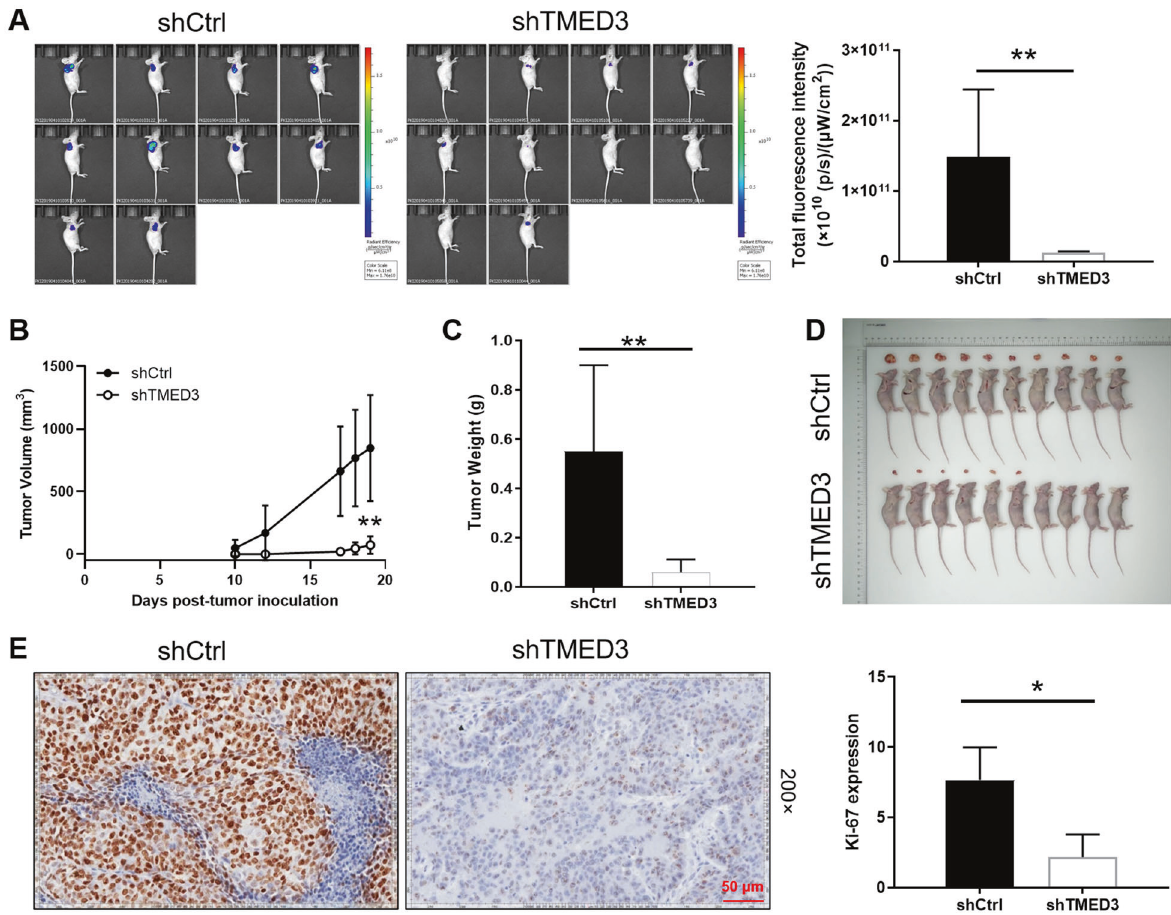
Fig. 3 Knockdown of TMED3 inhibits tumor growth in vivo. A The total fl uorescence intensity of tumors in shCtrl group and shTMED3 group. B The volume of tumors in shCtrl group and shTMED3 group was measured and calculated during experiments. C The weight of tumors in shCtrl group and shTMED3 group was measured after the sacri fi ce of mice. D The photo of xenograft tumors removed from the mice models in shCtrl and shTMED3 groups. E The Ki-67 index of the removed tumors was evaluated by IHC analysis (200 × magni fi cation: scale bar = 50 μ